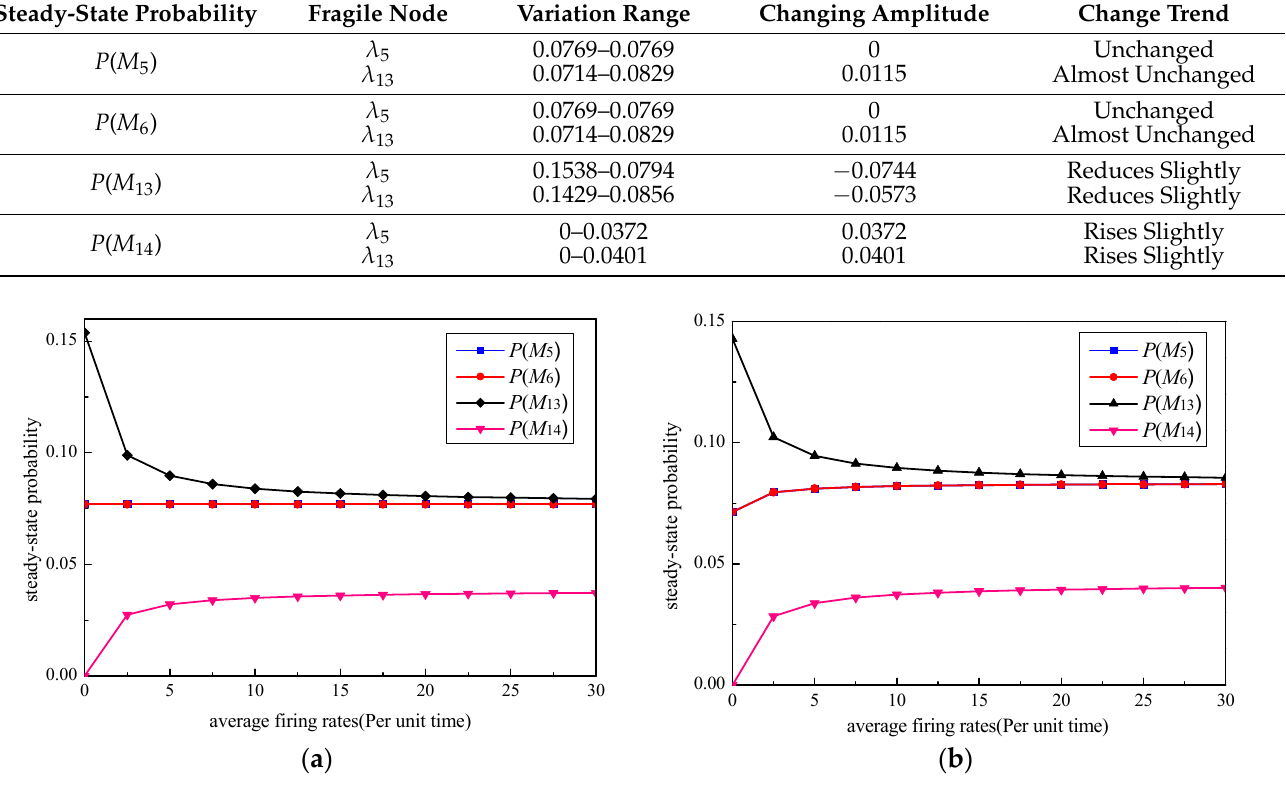
λ λ changes and ( b ) 13